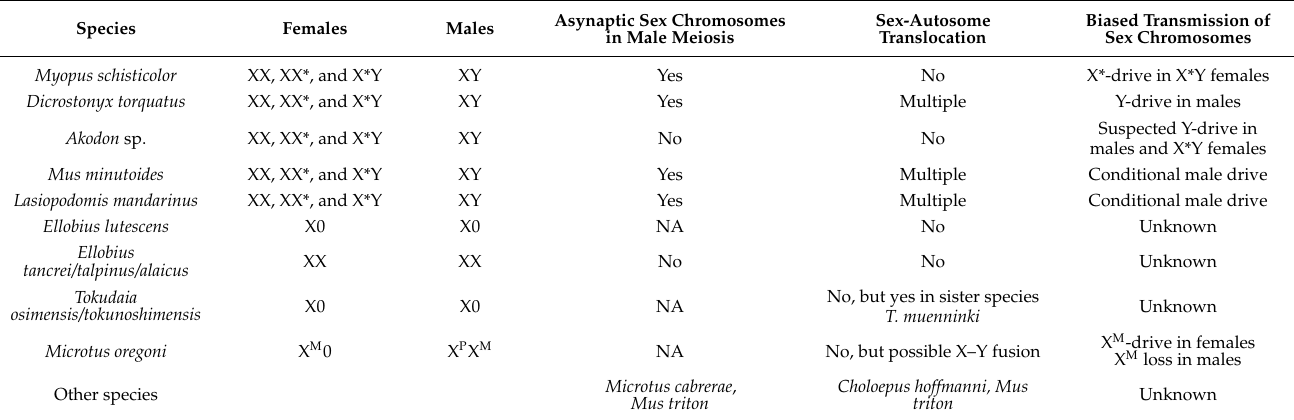
Table 1. Species with confirmed unusual sex-determining systems, and presence/absence of rare genomic features.